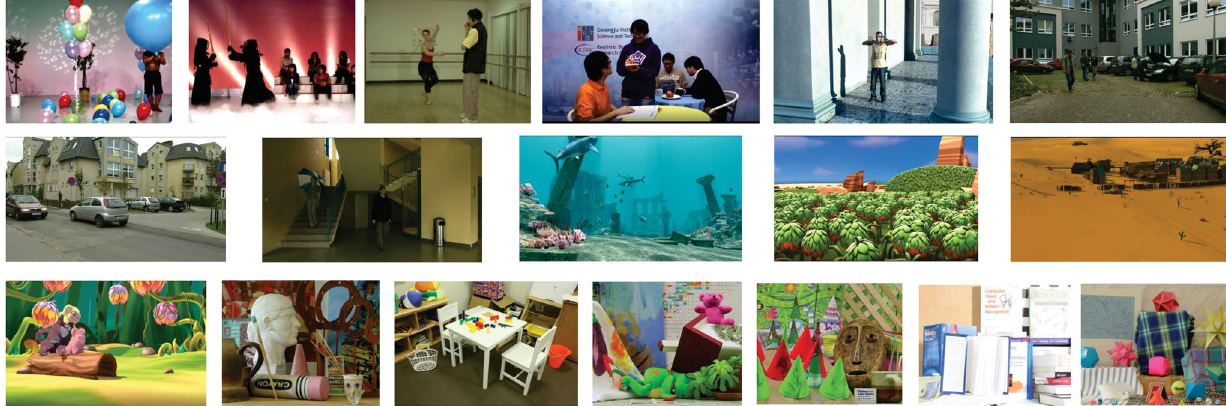
Fig. 6 Reference images from Nayoga Free-viewpoint video dataset [30], Microsoft 3D Video database [31], Poznan Multiview video test sequences [32], Freiburg stereo dataset [33], and Middlebury Stereo dataset